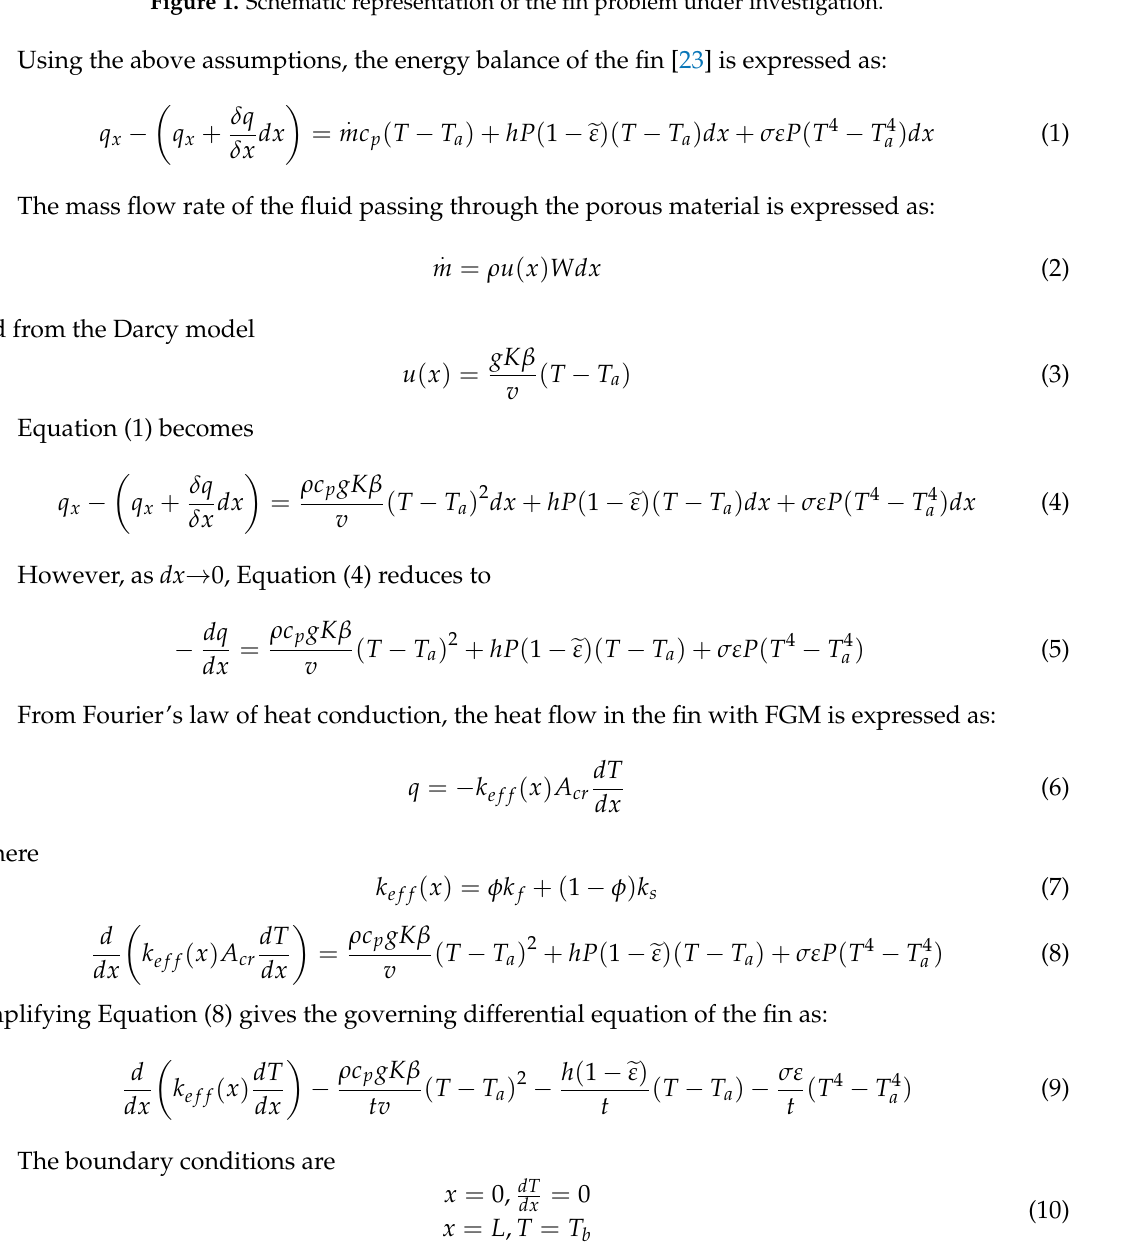
Figure 1. Schematic representation of the fin problem under